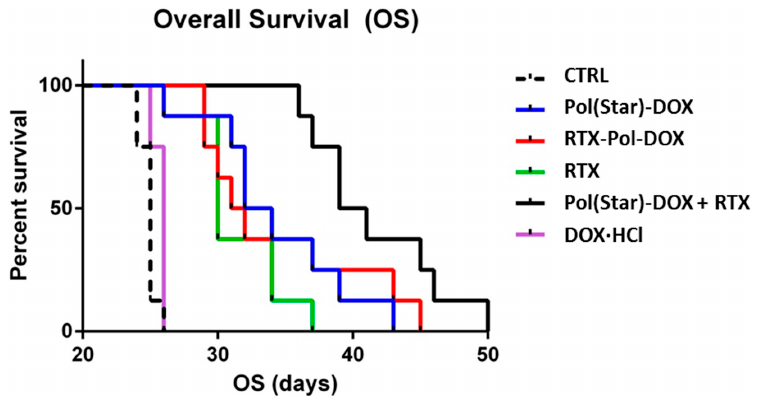
Figure 6. Comparison of anti-tumour activities of conjugate Pol(Star)-DOX , RTX-Pol-DOX , RTX, DOX·HCl and combination of RTX and Pol(Star)-DOX in human DLBCL lymphoma model (CTRL, non-treated). Overall survival was monitored. Based on these data, we conclude that targeting of polymer-bound anthracyclines with CD20 monoclonal antibody RTX does not prolong overall survival when compared with Pol(Star)-DOX .